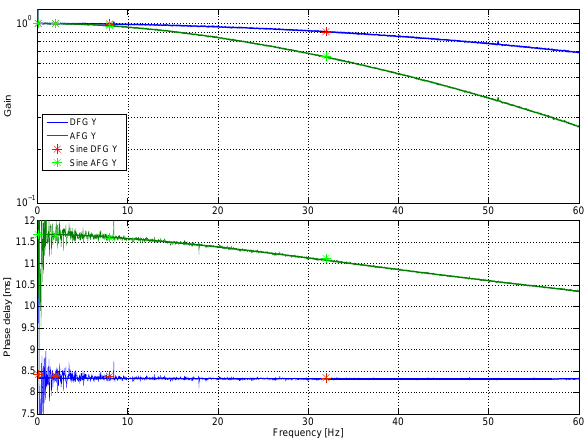
Figure 4. Frequency response of SCM measured with FFT esti- mation method and sine signals. FFT length is 32768; overlap is 32767; rectangular window; data duration of